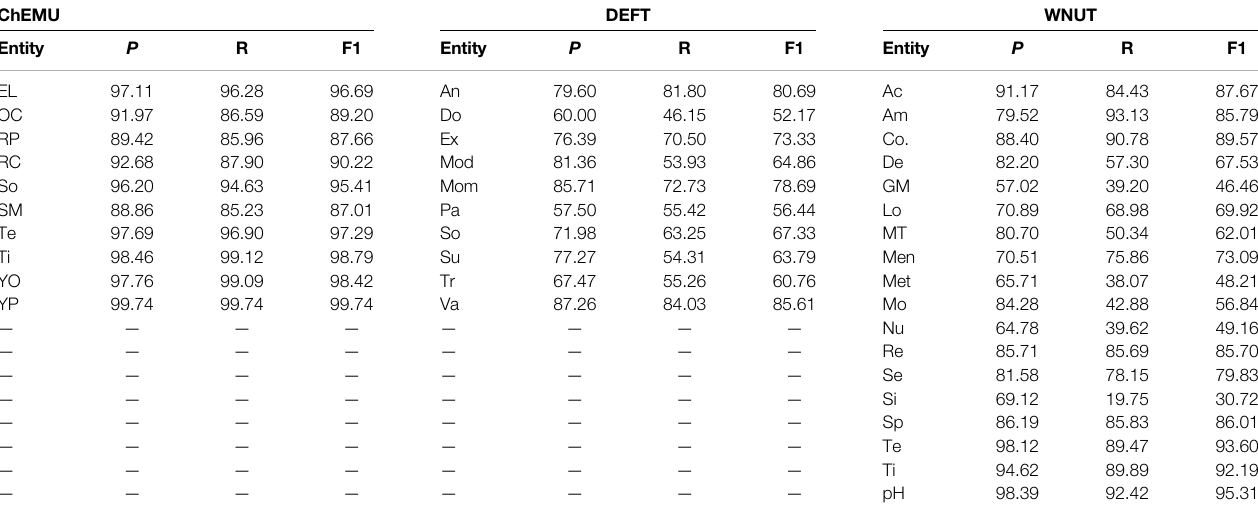
TABLE 8 | Performance of the ensemble models in terms of exact precision, recall, and F1-score for the entities of the ChEMU, DEFT, and WNUT of fi cial test sets. ChEMU DEFT WNUT